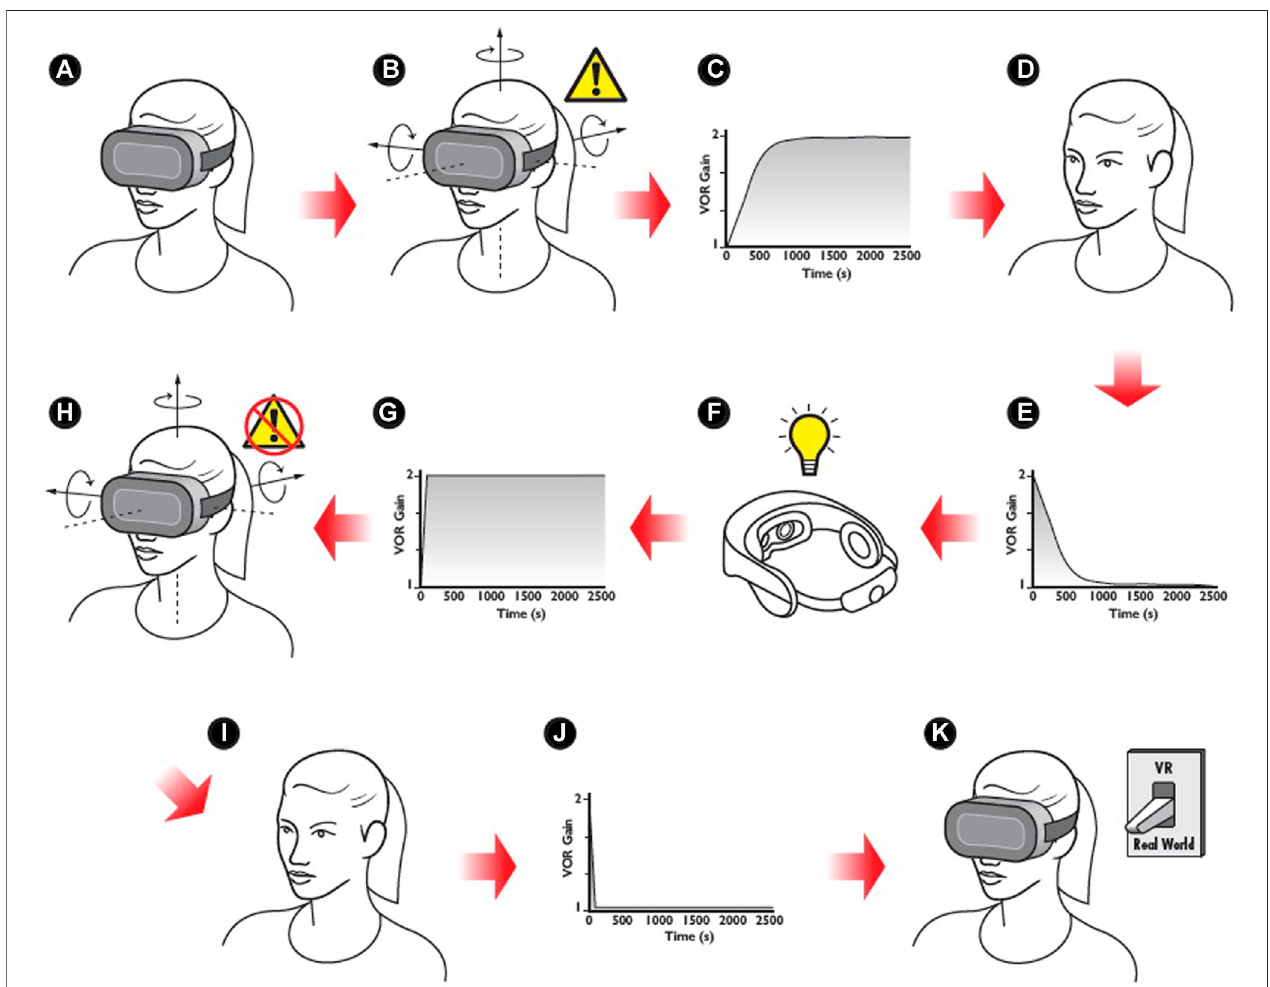
FIGURE1| HMD-VRconstitutesacontextforwhichavestibulo-ocularre fl ex(VOR)gaincanbelearnedandretrievedbasedonsensorycues. (A) .Anewuserdons anHMD-VR. (B) .Theuserexperiencesamismatchbetweentherotationalvelocity oftheheadandthatofthevisualscene,causingaretinalsliperror. (C) .Overtime,the adaptation of VOR gain reduces the retinal slip error. D. The user removes the HMD-VR. (E) . An aftereffect is experienced in the real world, causing retinal slip. VOR deadapts toreducethe error. (B – E) may repeat several times prior toF, resulting in the learning of the adaptation . (F, G) . Even sight or touch ofthe HMD triggers a “ preparatory ” change in VOR gain upon or even prior to entering the VR. (H) . Retinal slip is minimal or absent in the HMD-VR due to preparatory VOR adaptation. (I) . Removal ofthe HMD isaccompanied bypreparatory deadaptation ofVORgain. (J) . Aftereffects are greatly diminished due to preparatorydeadaptation. (K) . TheHMD- triggering this